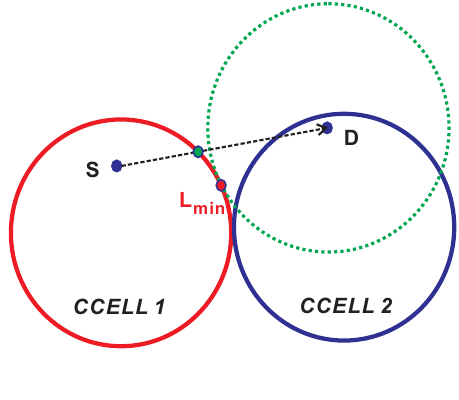
Figure 7. Failure of end-to-end greedy routing after global alignment of two spheres of mapped CCELLs. The packet from S to D will be stuck at L min , which is closest to D in CCELL 1.